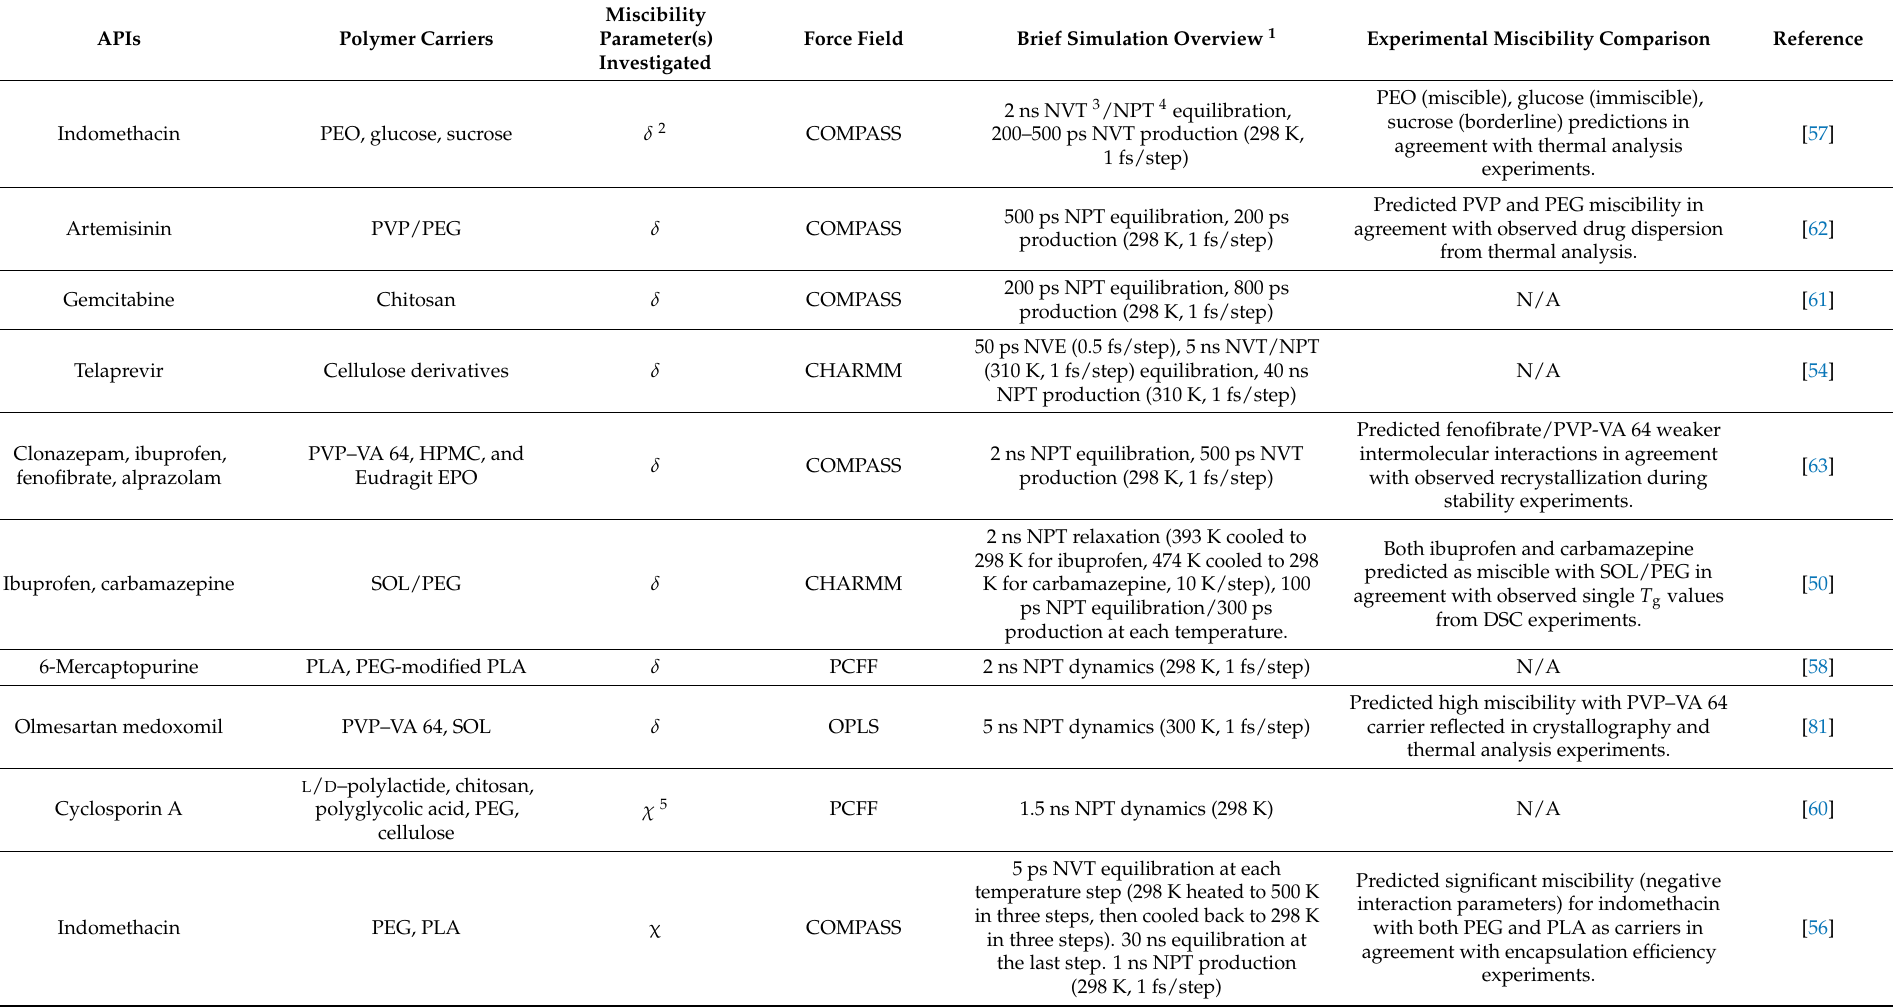
Table 3. Recent studies of ASD API–polymer miscibility from MD-derived solubility and interaction